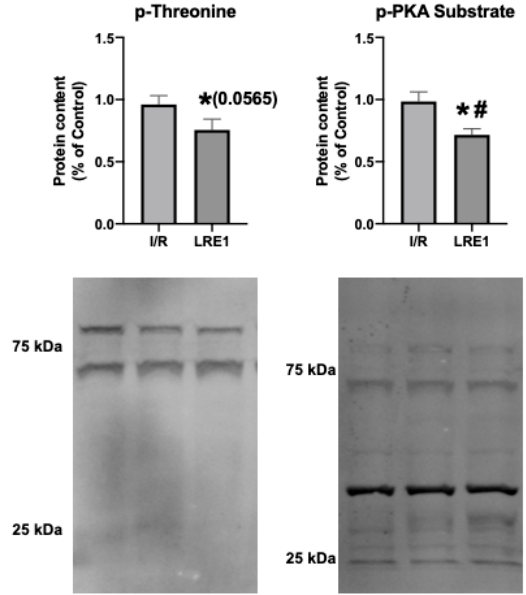
Figure 7. Hepatic mitochondrial protein phosphorylation content quantification by Western blot. Data are means ± SEM of 4 independent experiments. p-threonine, phosphorylated threonine residues; p-PKA substrate, phosphorylated PKA substrate. * indicates a statistically significant difference vs. Ctl; # indicates a statistically significant difference vs. I/R.